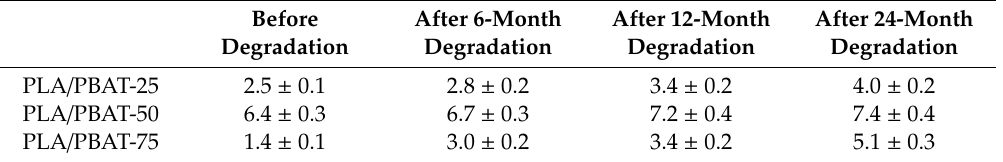
Table 1. The X c ( % ) of PLA / PBAT with di ff erent component proportion before and after degradation. Before After 6-Month After 12-Month After 24-Month Degradation Degradation Degradation Degradation PLA /